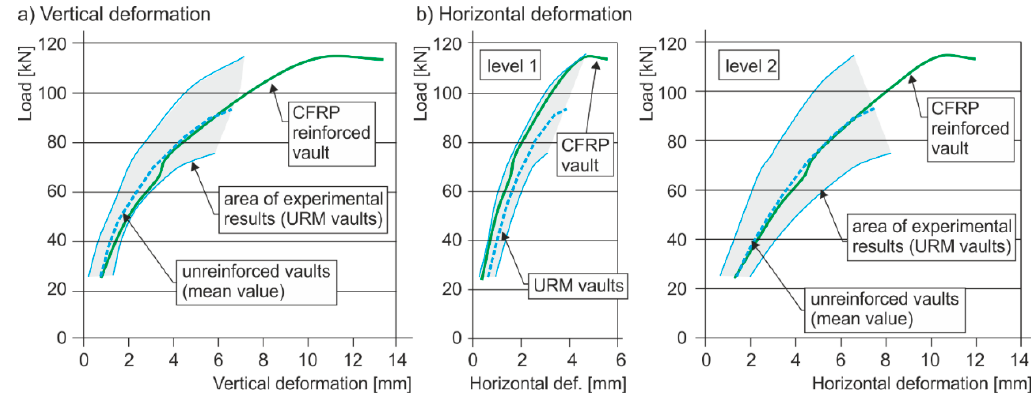
Figure 9. ( a ) Schematic of masonry barrel vault’s reinforcement with strips of carbon fabrics. ( b ) Ultimate loads for unreinforced and reinforced vaults (Helikal reinforcement was one of the originally considered stabilization methods for the arcade walk damaged vaults).